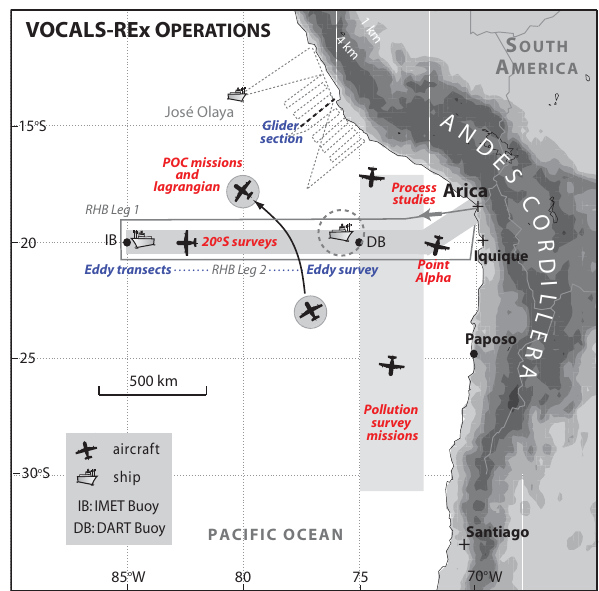
Fig. 2. VOCALS REx study region showing main sampling plat- forms and mission types. The land aerosol/meteorology site at Pa- poso, the sounding station at Iquique, and the instrumented IMET and DART buoys are also